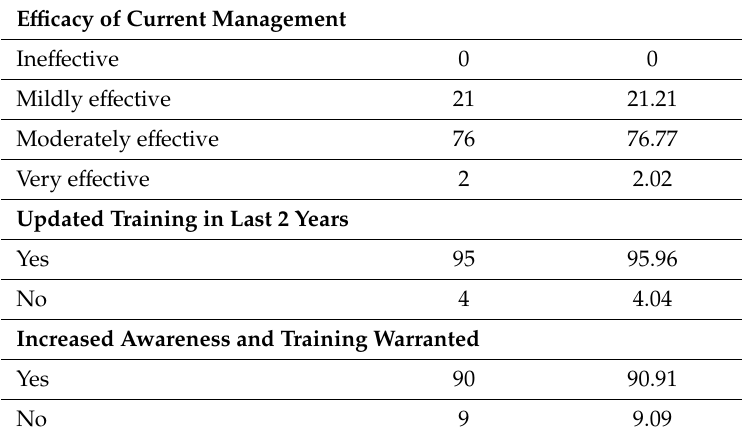
Table 8. Practitioners’ Attitude Towards